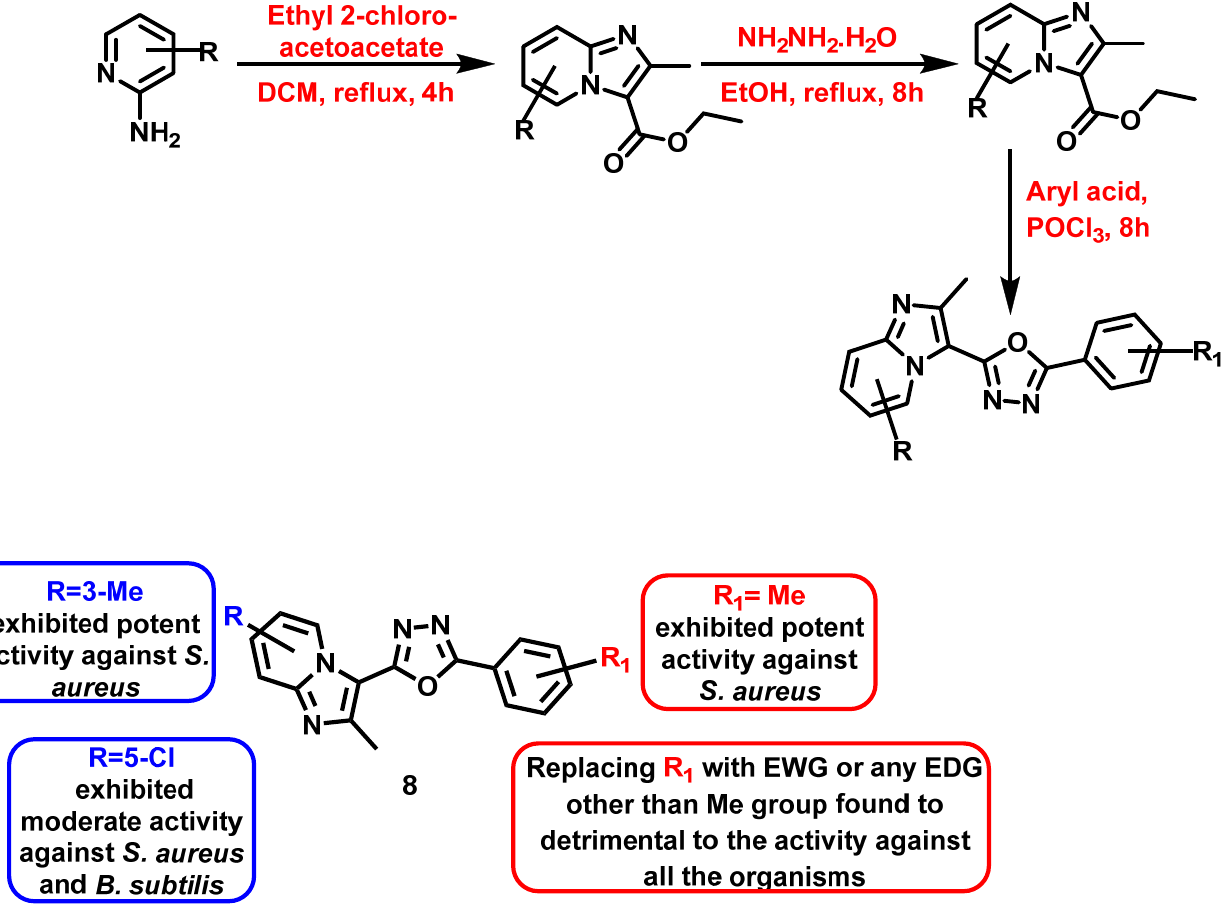
substitution on the nitrogen of the pyrazole moiety with aryl or aryl substituted groups enhanced the antibacterial activity of the compounds.